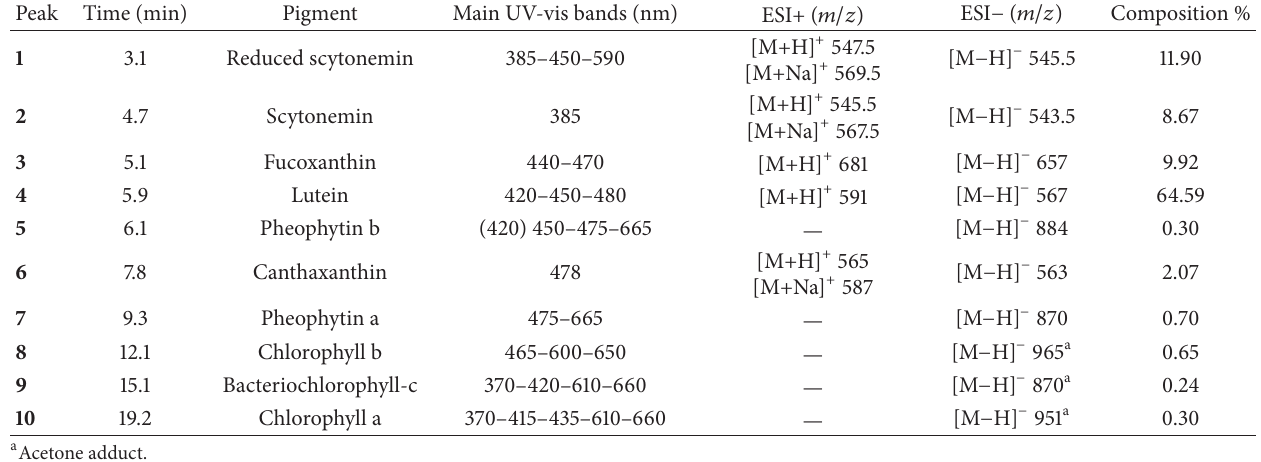
Table 1: Pigments in Edmonson Point lake sediments identified using DAD and ESI mass spectra.